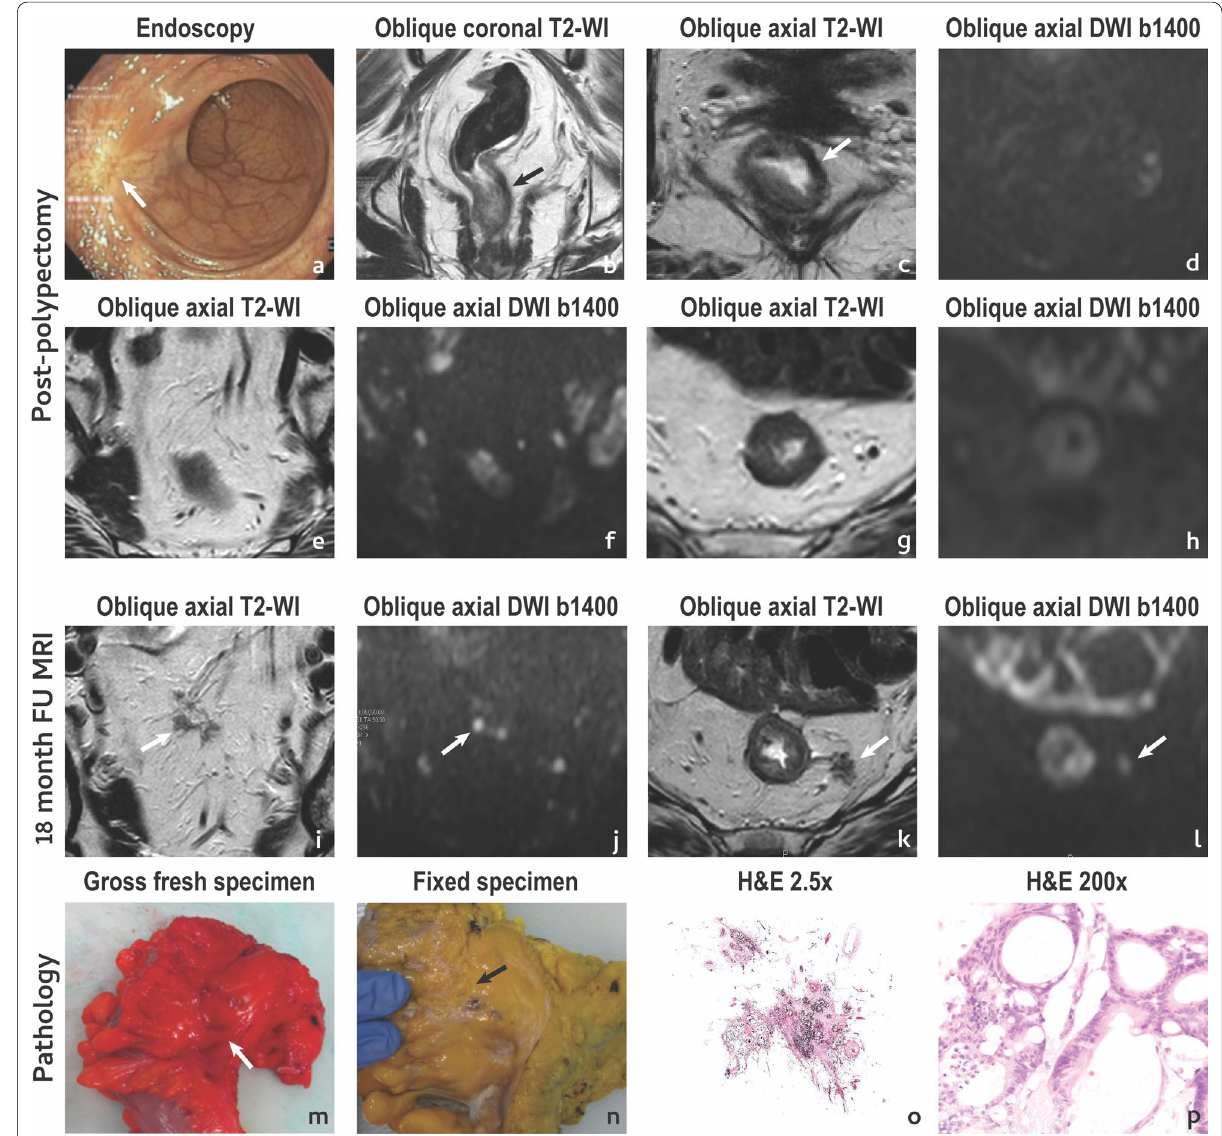
Fig. 10 Extra-rectal pelvic recurrence. A 62 year-old female with rectal bleeding presented with a 34 mm polyp at colonoscopy which was excised revealing a tubulovillous adenoma with moderately differentiated adenocarcinoma, mucinous type, invading the muscularis propria with a focally positive margin in depth. No residual tumour was apparent on MR imaging or endoscopy at post-polypectomy assessment ( a – d ) and no extra-rectal suspicious findings were found either ( e – h ). Patient underwent long course chemoradiation and was followed. Findings were stable until the 18th month of follow-up, when irregular, heterogeneous, intermediate signal foci were found cranially to the polypectomy scar, within the mesorectal fat, at two different levels (arrows in i , j and k , l ). Patient underwent total mesorectal excision and the MR imaging findings corresponded to extranodal tumour deposits of intestinal type adenocarcinoma with mucinous areas. The extranodal tumour deposits in i , j are shown in the fresh ( m ) and fixed ( n ) pathology specimen and at hematoxilin eosin staining both at low (